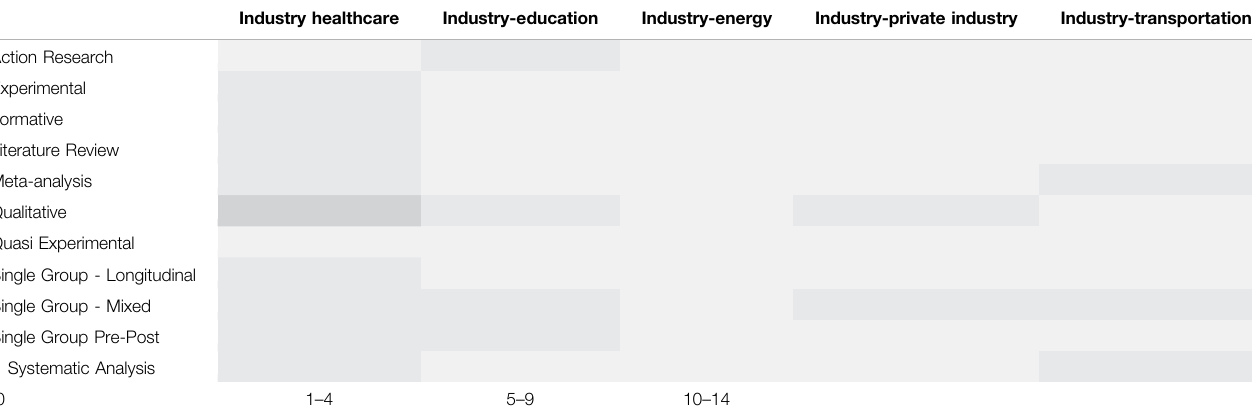
TABLE 7 | Matrix query results: Industry and research